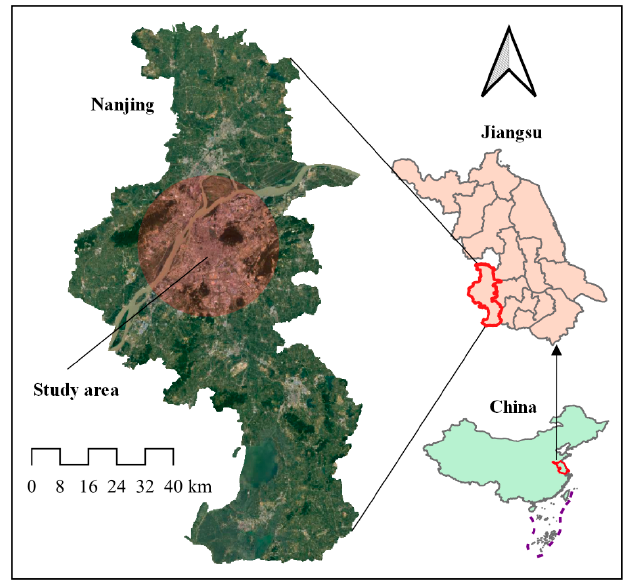
Figure 1. The study area of Nanjing, Jiangsu, China. Background from Google Earth Imagery [47].